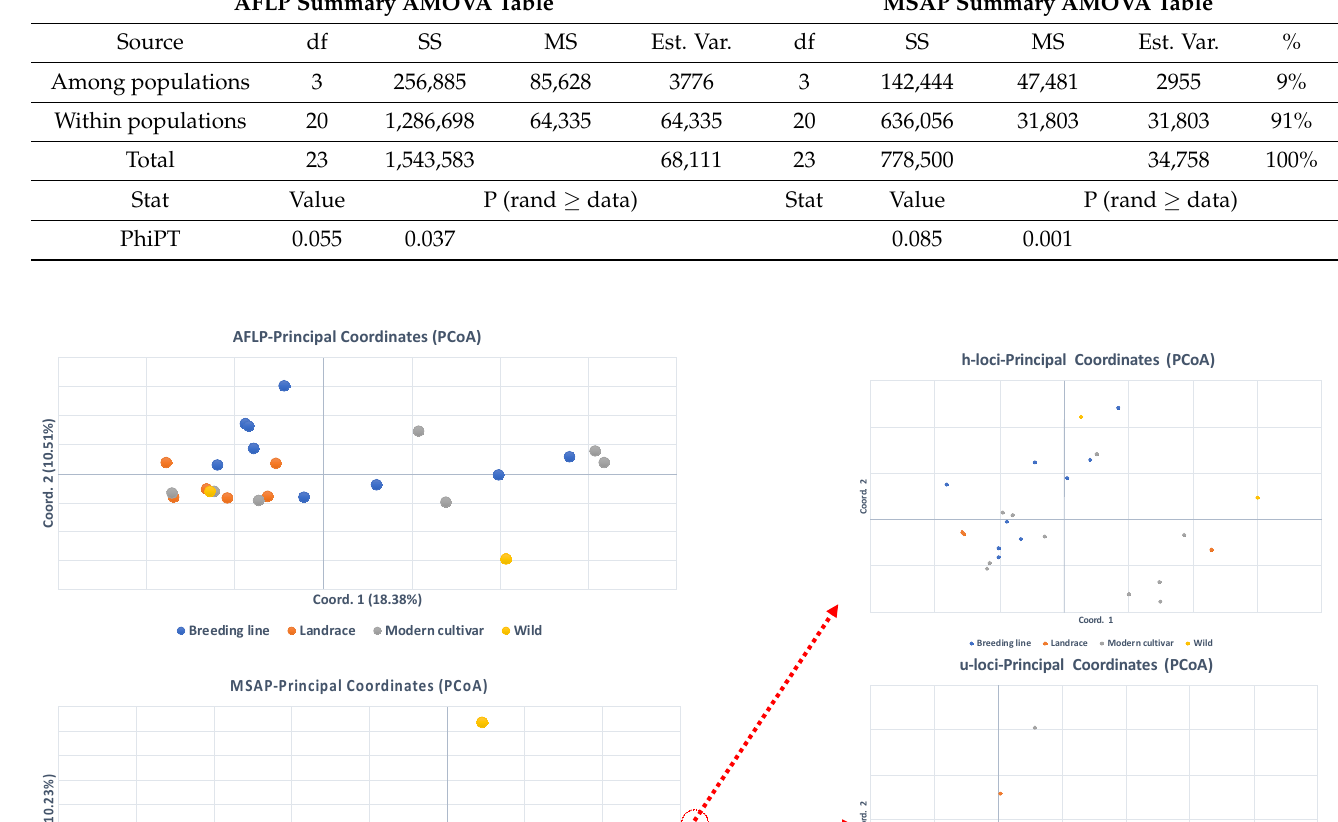
Table 4. Analysis of molecular variance (AMOVA) table for genetic (AFLP) and epigenetic (MSAP) data. AFLP Summary AMOVA Table